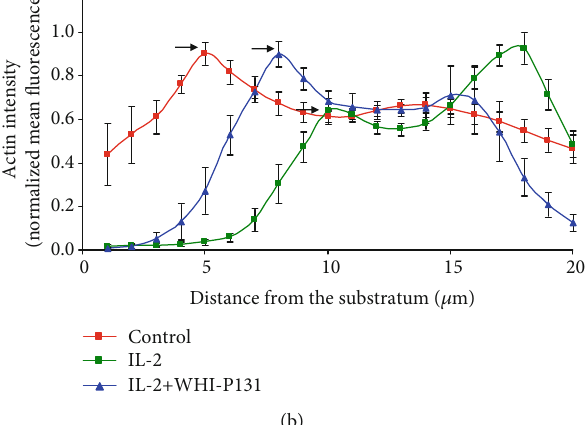
Figure 2: IL-2-stimulated Jak3 activation leads to disassembly of actin fi laments from the basal plane of migrating cells. (a) Planar distribution of f-actin in HT-29 Cl-19A cells at the wound edge of control cells; cells treated with IL-2; and cells treated with IL-2+WHI- P131. The lower images in each panel are the corresponding bright fi eld images. (b) Normalized f-actin intensity for each plane as a function of the distance from the substratum